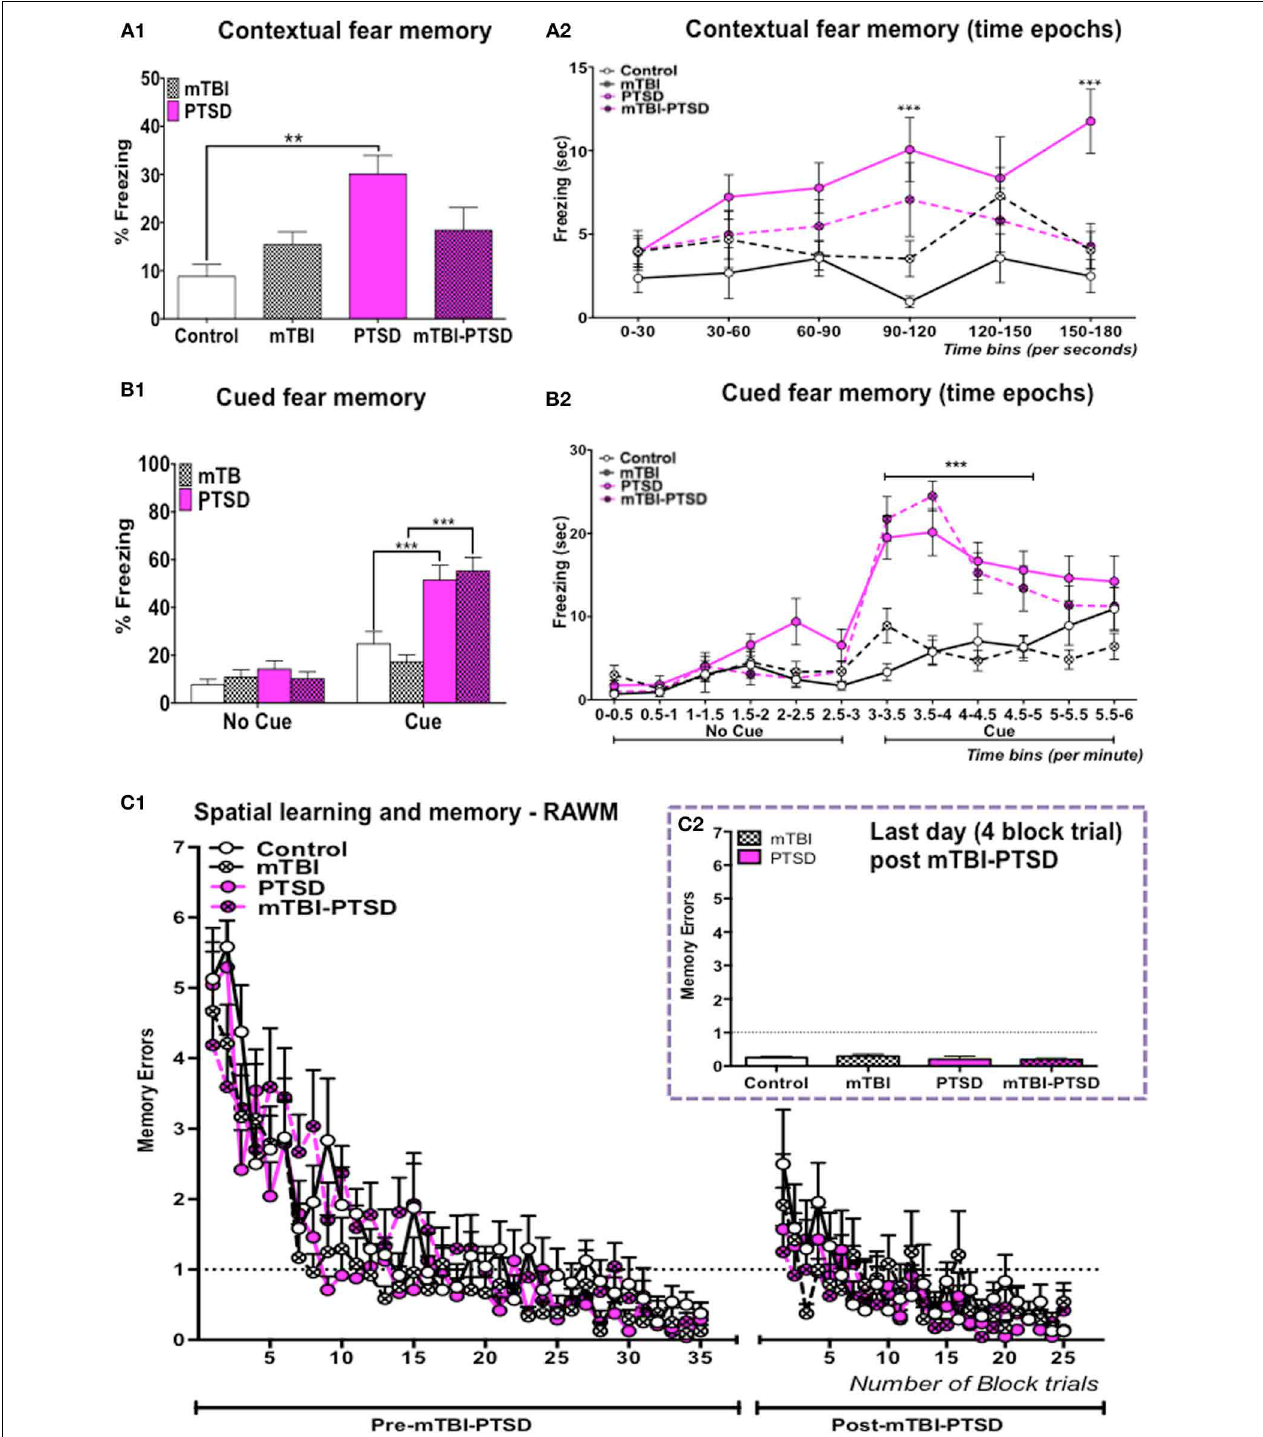
FIGURE 2 | Contextual, cued fear, and spatial memory. PTSD animal group showed a significant increase in their (%) freezing responses to both the context (A1,A2) and the auditory cue (B1,B2) , compared to control animals. mTBI inhibited the retrieval of the contextual fear memory response in the mTBI-PTSD group (A1,A2) , there was no effect of mTBI on the cued fear response in the mTBI-PTSD group (B1,B2) . No significant effect was seen in the fear memory response from the mTBI only group compared to the control